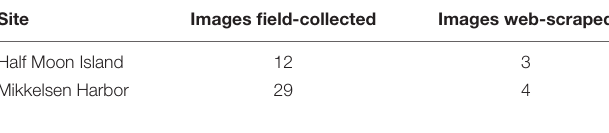
TABLE 2 | Images from two sites of focus for